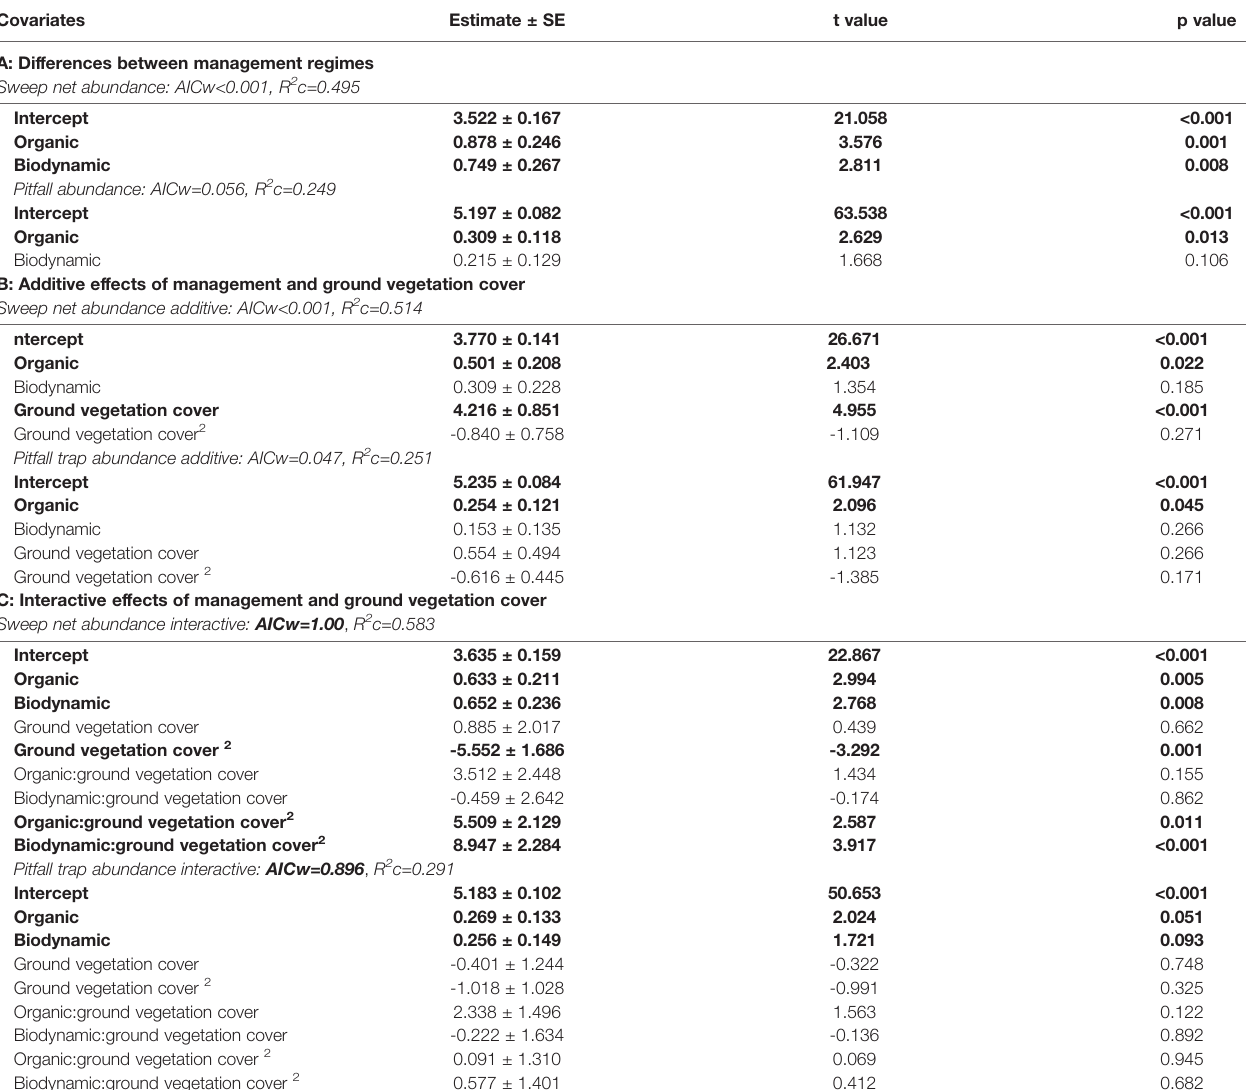
TABLE 1 | Estimates of the three different models (A) : management regime only; (B) : management regime + ground vegetation cover; (C) : management regime*ground vegetation cover) for invertebrate abundance with respect to sampling method. Covariates Estimate ± SE